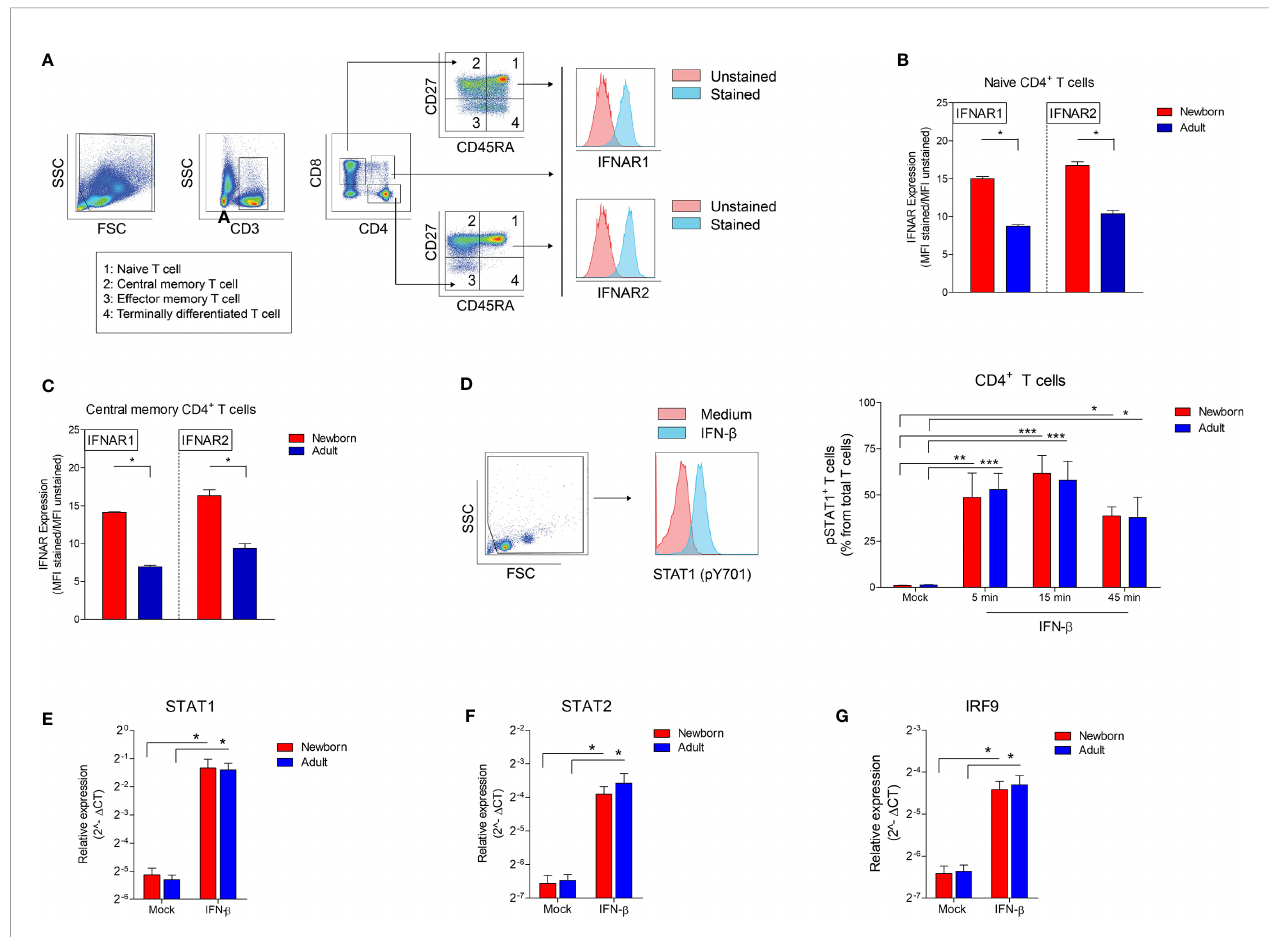
FIGURE 3 | High IFNAR expression and similar induction of phosphorylated STAT1 and STAT1-induced transcription factors in newborn CD4 + T cells. (A) Representative gating to determine IFNAR1 and IFNAR2 expression on CD4 + T cell subsets. CD3, CD4 and CD8 was used to identify CD4 + T cells and CD8 + T cells. CD45RA and CD27 was used to identify T cell subsets: naïve (CD45RA + CD27 + ), central memory (CD45RA - CD27 + ), effector memory (CD45RA - CD27 - ) and terminally differentiated (CD45RA + CD27 - ) T cells. (B) Expression of IFNAR1 and IFNAR 2 on newborn and adults naïve (B) and central memory (C) T cells. (N=4-5). (D) Presence of phosphorylated STAT1 in newborn and adult CD4 + T cells upon exposure to IFN- b . (N=3-6). (E – G) Expression of (E) STAT1, (F) STAT2 and (G) IRF9 mRNA in newborn and adult CD4 + T cell after exposure to medium or IFN- b for 2h. (N=5-6). Data are presented as means ± SEM. * = P <0.05. ** = P <0.01. *** = P